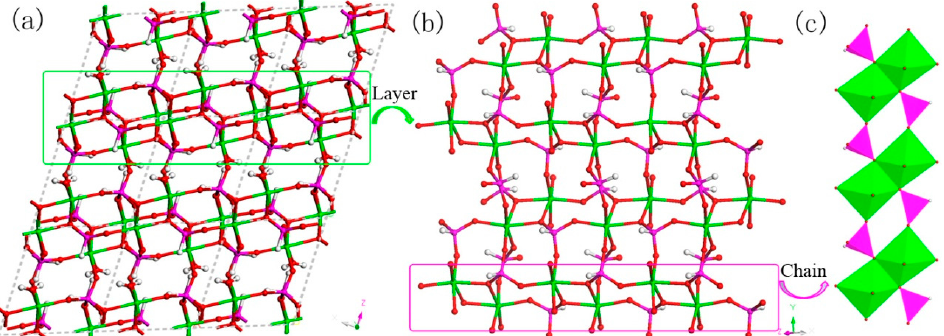
Figure 7. ( a ) The pillared-layer structure of 3 along (001) direction. ( b ) The dense four-ring layer structure of 3 in (101) plane. ( c ) One-dimensional (1D) four-ring chain containing In 2 O 10 cluster. P, pink; In, green; H, white; O, red.